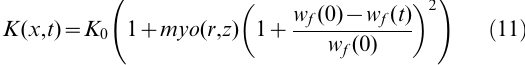
Figure S1 Distribution of GFP-myosin II motors during cytokinesis. A. Dividing cells were imaged at five time points approximately 100 seconds apart during cytokinesis, and the fluorescence intensity was measured around the cell perimeter. B. Furrow diameter as a function of time. During the simulation, the furrow diameter is measured to determine where the cell is along this profile. C. Spatial distribution of myosin II motors along the division axis ( z ) at different time points. During the simulation, the myosin II forces were distributed according to these profiles indexed by the furrow diameter. Figure S2 Simulation of furrow ingression with no protrusion. A. This cell model includes myosin II contractile forces, adhesion, but no protrusive forces. As shown, these cells stalled. B. Comparison of furrow diameter between simulations in panel A with WT dynamics (reproduced from Fig. 3B). Figure S3 Furrow thinning trajectory for varying elas- ticities. Elastic constant ( K in Fig. 5B) was increased ( + 40%) and decreased ( 2 30%) and the resultant furrow thinning dynamics were compared to the nominal (WT) model. Figure S4 Effect of adhesion. System response to step applications ( s step ) of 1 nN/ m m 2 , for various levels of adhesion (ranging from 0 to 100% of maximum). Simulations that incorporate greater adhesion show a delayed initial response to the stress. These cells also take longer to reach steady state after removal of the stress. Figure S5 Profiles of different stresses at various time points for an adherent myoII null cell. Negative stresses denote inward-directed forces. Video S1 Simulation of model incorporating adhesion and protrusion forces. (AVI) Video S2 Simulation of model incorporating spatially heteroge- neous cortical tension, adhesion and protrusion. (AVI) Video S3 A myoII cell undergoing cytokinesis. Movies were collected with two second intervals. Video S4 Simulation of model incorporating spatially heteroge- neous cortical tension and myosin II-dependent contractile force. (AVI) Video S5 Simulation of model incorporating spatially heteroge- neous cortical tension, myosin II-dependent contractile force, adhesion, and protrusion. Video S6 Simulation of model incorporating spatially heteroge- neous cortical tension, myosin II-dependent contractile force, adhesion, protrusion, and strain